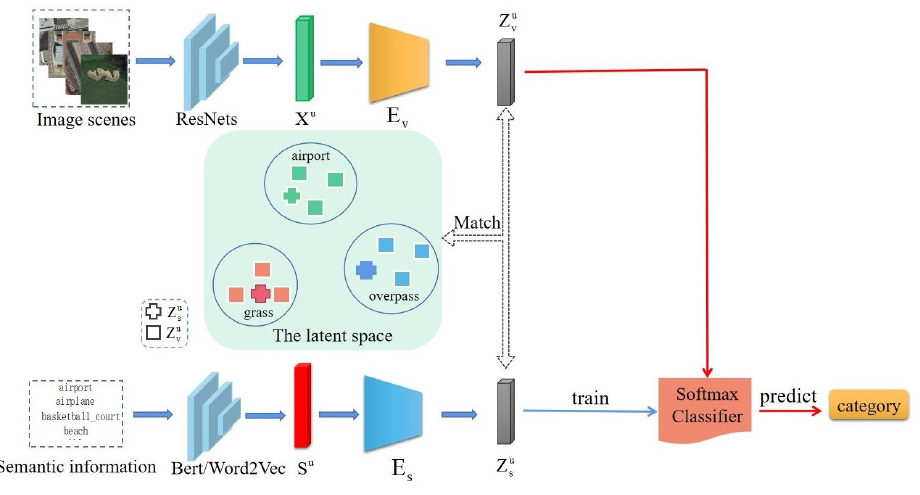
Figure 1. The overview of the cross-modal feature alignment method for zero-shot remote sensing image scene